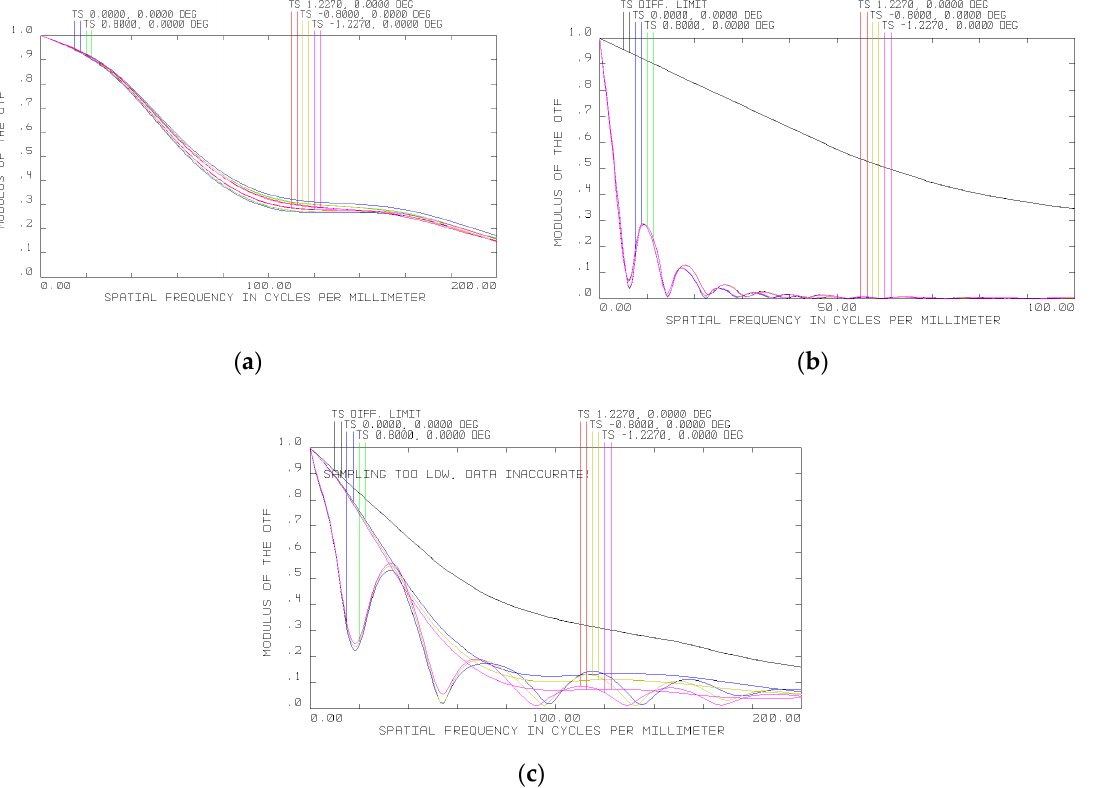
Figure 6. MTF of hyperspectrometer at ( a ) 20 °C, ( b ) − 40 °C, and ( c ) 45 °C.